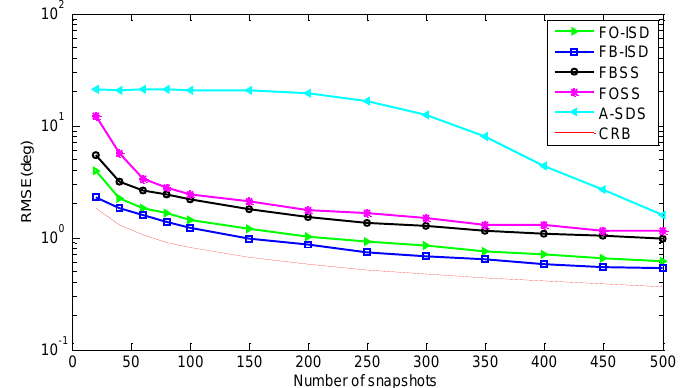
Figure 7. RMSE curves versus the number of snapshots in the white noise